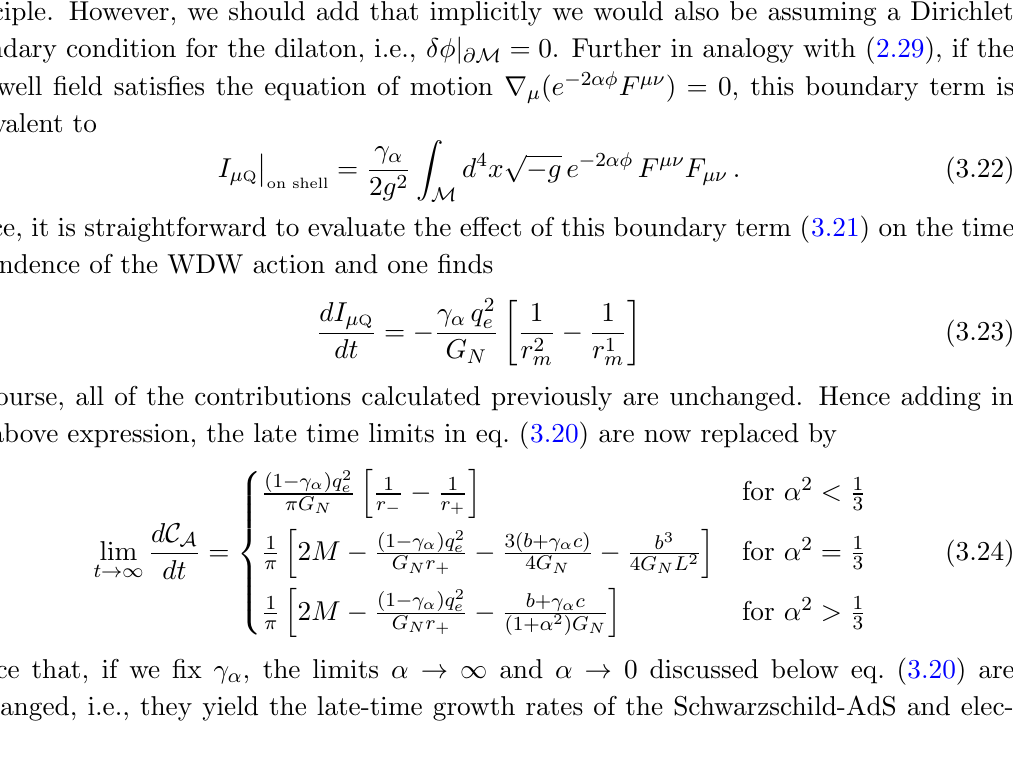
Figure 7 . The time dependence of complexity for an electrically charged Maxwell-Dilaton black hole (without the addition of the Maxwell boundary term). We evaluate for concreteness (cid:11) = 1 = which corresponds to a black hole with a causal structure that resembles that of an Schwarzschild- AdS black hole. The parameters are chosen to be ‘ In analogy to the Schwarzschild-AdS black hole, the complexity does not change until a certain critical time, where the WDW patch leaves the past singularity. Then, the complexity approaches the late time limit from above, with a transient dependence on ‘ inverse